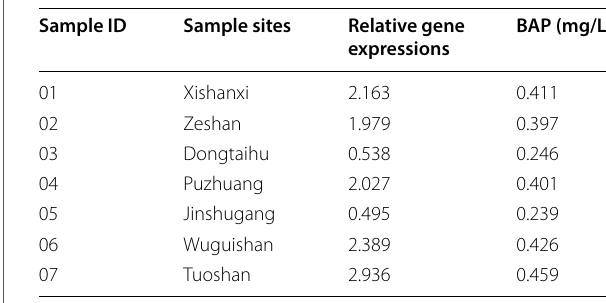
Table 3 Concentrations of bioavailable phosphorus